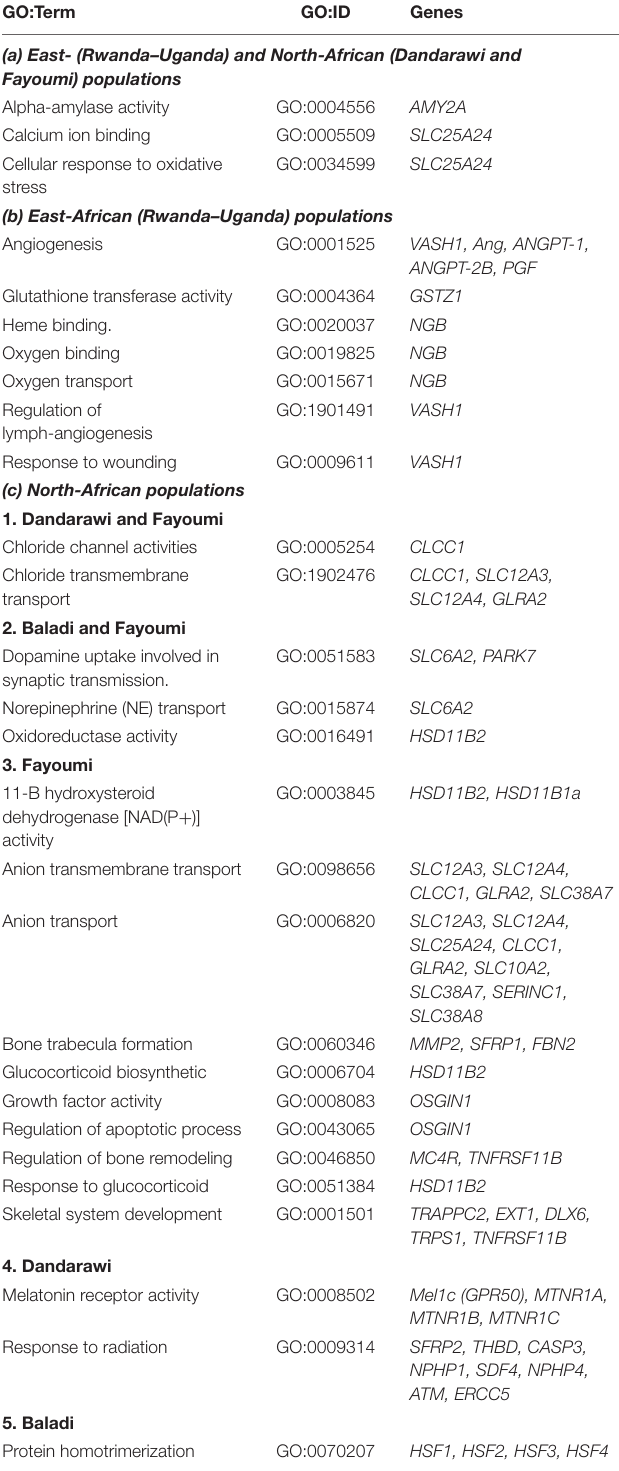
TABLE 1 | A subset 1 of gene ontology (GO) enrichment of consensus ROH analysis, and annotated genes in (a) East- and North-African populations, (b) East-African populations, and (c) North-African